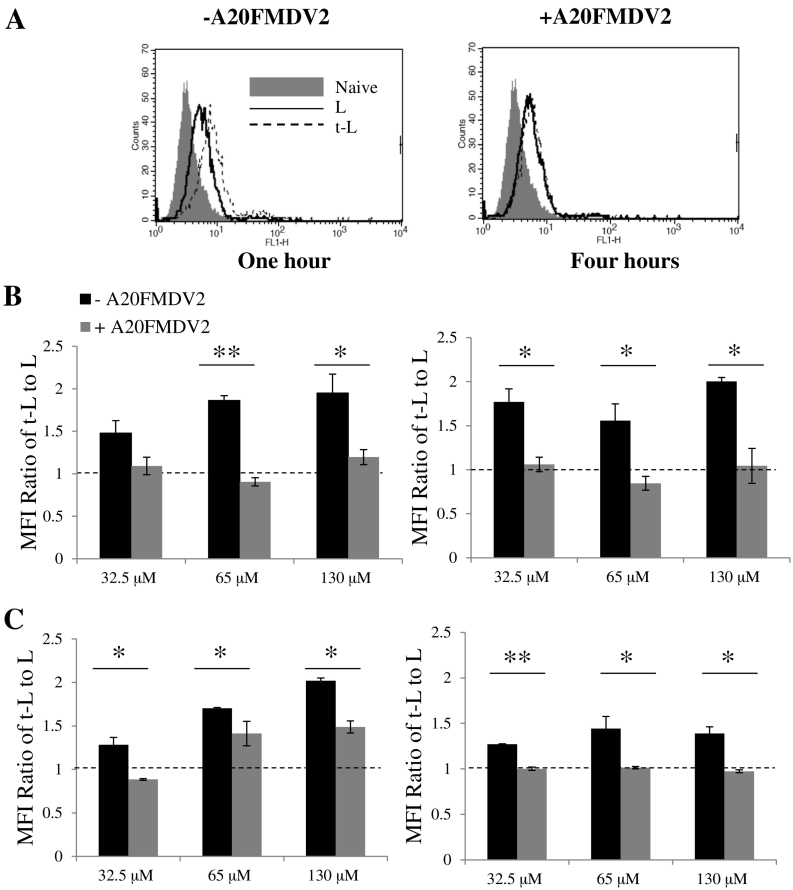
Cellular uptake of fluorescent liposomes in αvβ6 positive cancer cell lines in vitro. A375Pβ6 and PANC0403 cells were incubated with L or t-L labelled with 1 mol% CF-DOPE for either 1 or 4 h. Cells were pre-treated on ice with either normal media (black bars) or media containing 50 μg/ml (grey bars) of the free A20FMDV2 peptide for 10 min prior to addition of the liposomes. Cellular uptake was assessed by measuring the mean fluorescence intensity (MFI) using flow cytometry (A) Flow cytometry plots demonstrate the reduction in t-L uptake in A375Pβ6 cells in the presence of free A20FMDV2. (B) A375Pβ6 showed reduced uptake of t-L when incubated with free A20FMDV2 at both 1 and 4 h. (C) Similarly, PANC0403 cells also showed a reduction in targeting ability of t-L when incubated with free A20FMDV2. *p < 0.05, **p < 0.01 (Student's t-test + A20FMDV2 vs. –A20FMDV2).